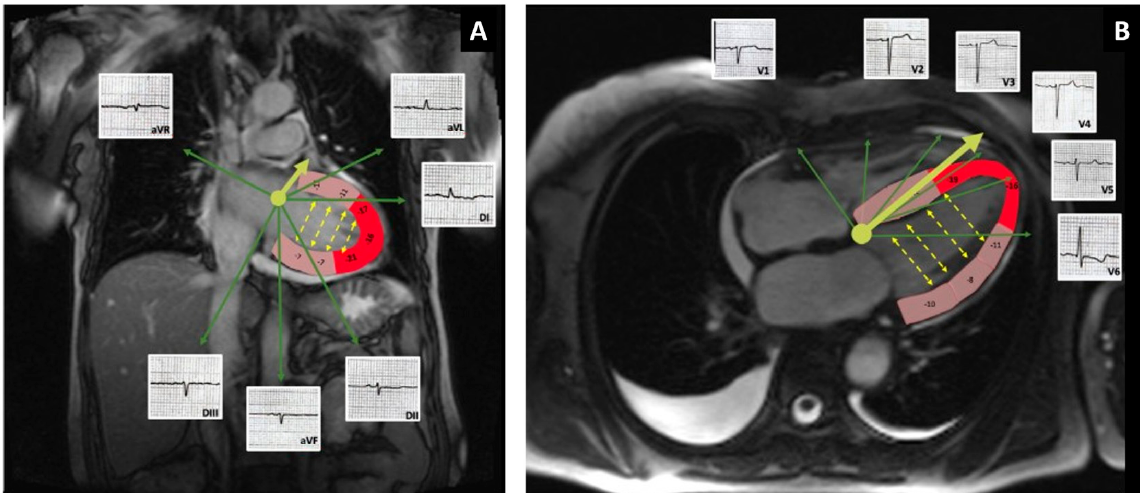
Figure 4. Potential mechanism responsible for the discordance in voltage between frontal ( A ) and precordial leads ( B ) . Fused cMRI-GLS images with examples of ECG waves on leads V1–V6. Segments of the LV are color-coded based on local strain values: red corresponds to local strain ≤− 16%; pink local strain > − 16%. The solid yellow arrow represents the QRS axis. The dotted yellow arrows represent direction of cancellation of electrical forces between opposing walls. The relative apical sparing pattern could be related to the high voltage seen in the precordial leads.